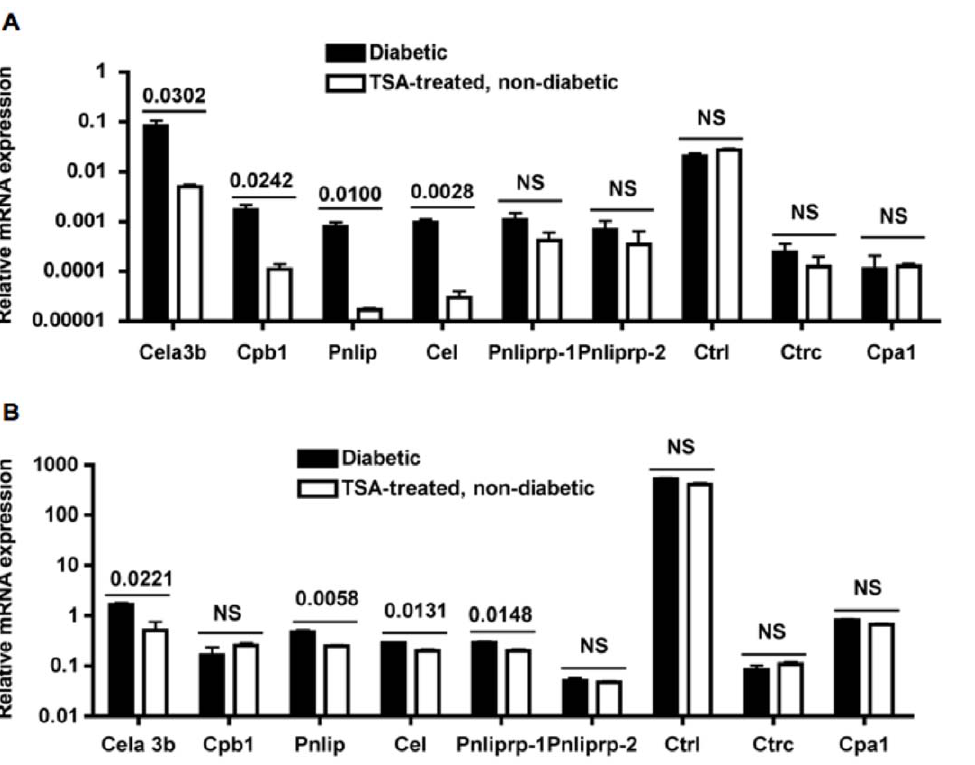
Figure 4. Repression of gene expression in splenocytes and pancreata by TSA treatment. ( A ) Total RNA was extracted from splenocytes of 24–28 wk old overtly diabetic mice and 28–34 wk old TSA-treated and cured mice that were different from those used for microarray analysis. RNA was converted into cDNA and used for validation of microarray data by qRT-PCR. ( B ) Expression of the same set of genes was determined by using RNA isolated from pancreata of diabetic and cured mice. Mean + / 2 SD of triplicate determinations from a representative of 2–3 experiments are shown. In each experiment, RNA was pooled from 3–5 mice. P values between groups are indicated. NS, not significant.